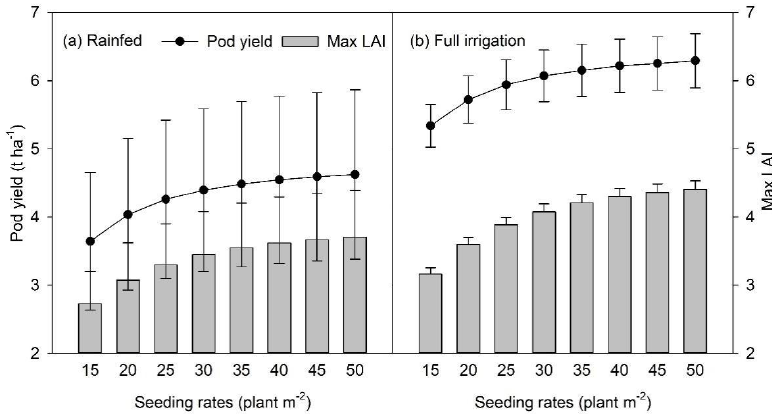
Figure 9. Simulated pod yield and maximum LAI of peanut of different seeding rates under rainfed ( a ) and full irrigation ( b ). Values are means of 494 data points.